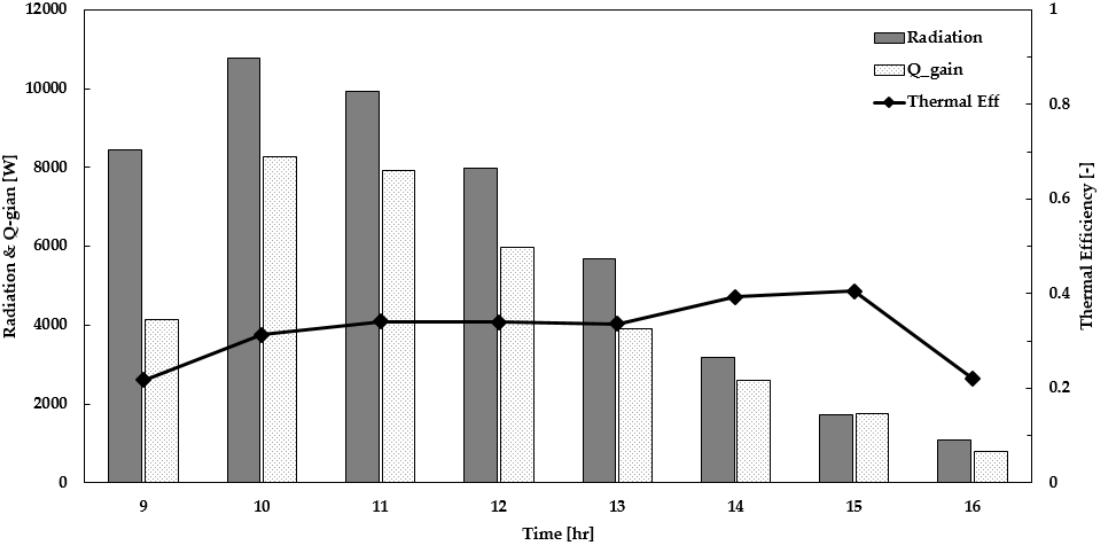
Figure 16. Daily thermal performance of the air-type BIPVT collector.